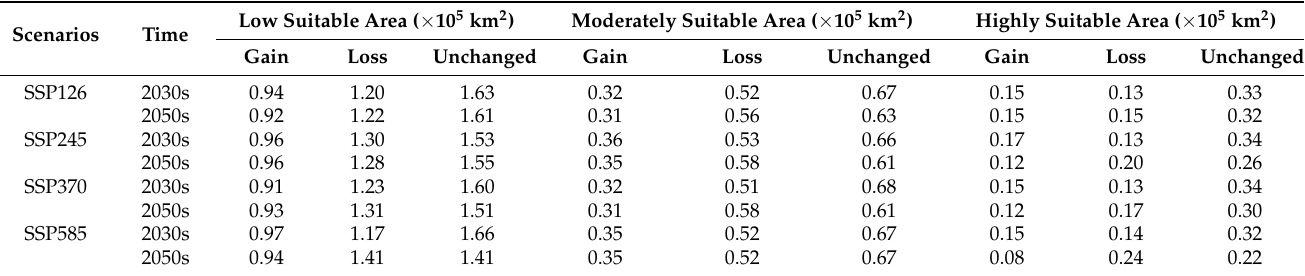
Table 2. Changes in the potential habitat area of typical locust species relative to the current area based on different climate